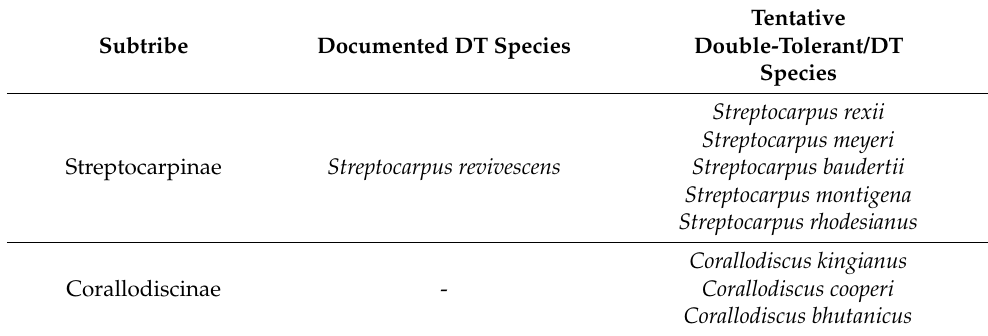
Table 1. Tentative new double-tolerant/DT species proposed according to the phylogenetic, geo- graphical, and morphological patterns already